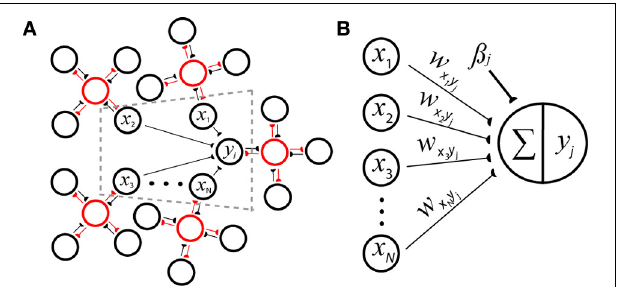
FIGURE 1 | Reconciling neuronal and probabilistic spaces using the spike-based BCPNN architecture for a postsynaptic minicolumn with activity y j . (A) A cartoon of the derived network incorporates H = 5 hypercolumns each containing n h = 4 minicolumns that laterally inhibit each other (red lines) to perform a WTA operation via local inhibitory interneurons (red circles). The dotted gray area is represented by B in detail. (B) Weighted input rates x 1 ... N are summed and passed through a transfer function to determine the amount of output activation. Connections w x can be viewed as synaptic strengths (black lines, semicircles) or inverted directed acyclic graph edges representing the underlying generative model of a naïve Bayes